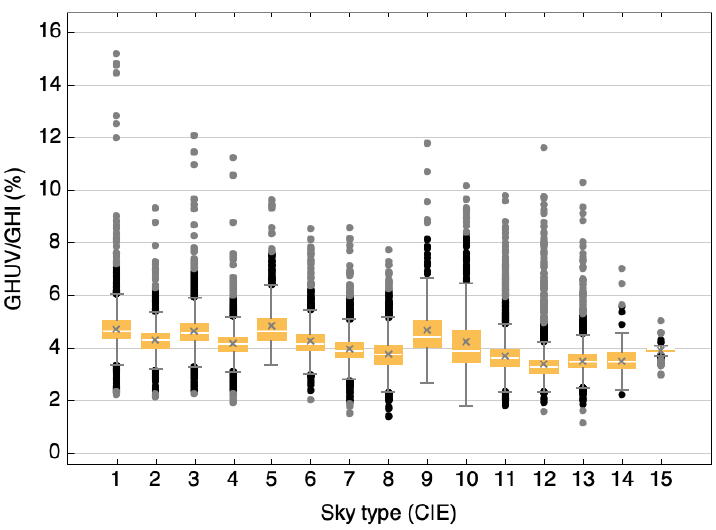
Figure 9. Boxplot of the average GHUV/GHI ratios for each CIE sky type using the 10 min data.